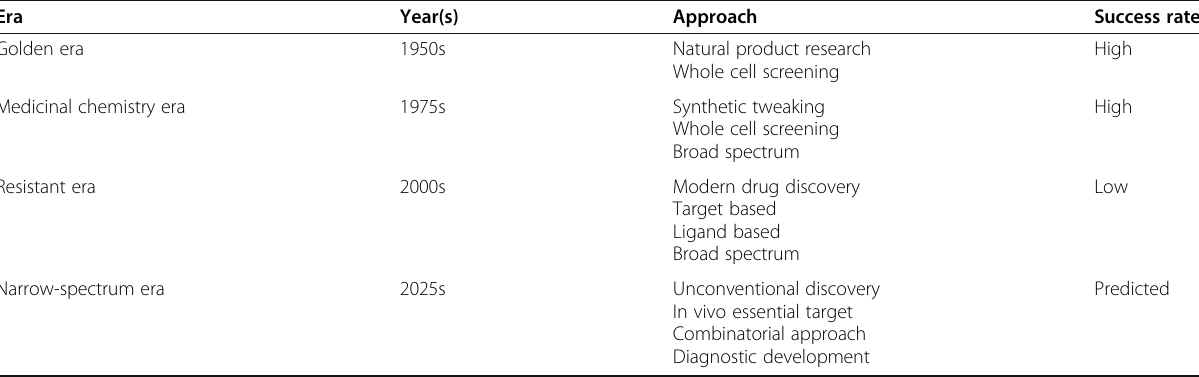
Table 5 Various timeline dependant drug discovery approaches and the expected success rate